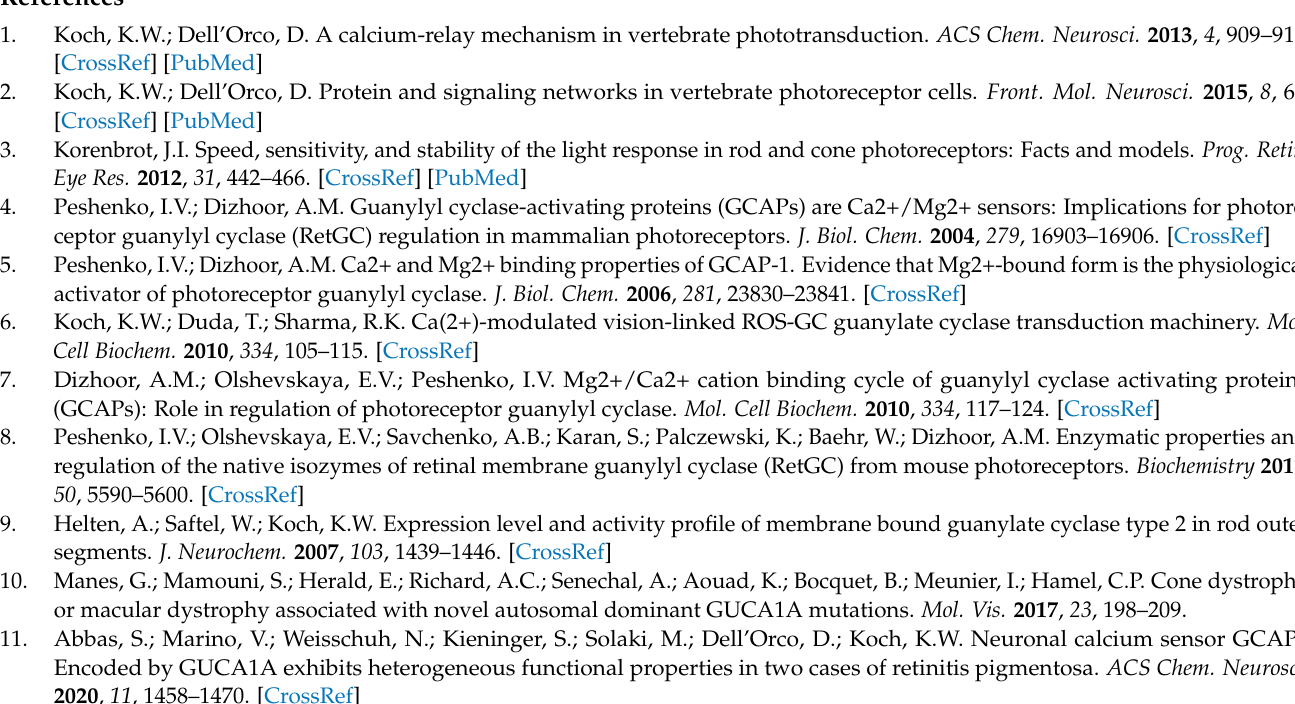
Table S2. RMSF of cations bound to GCAP1